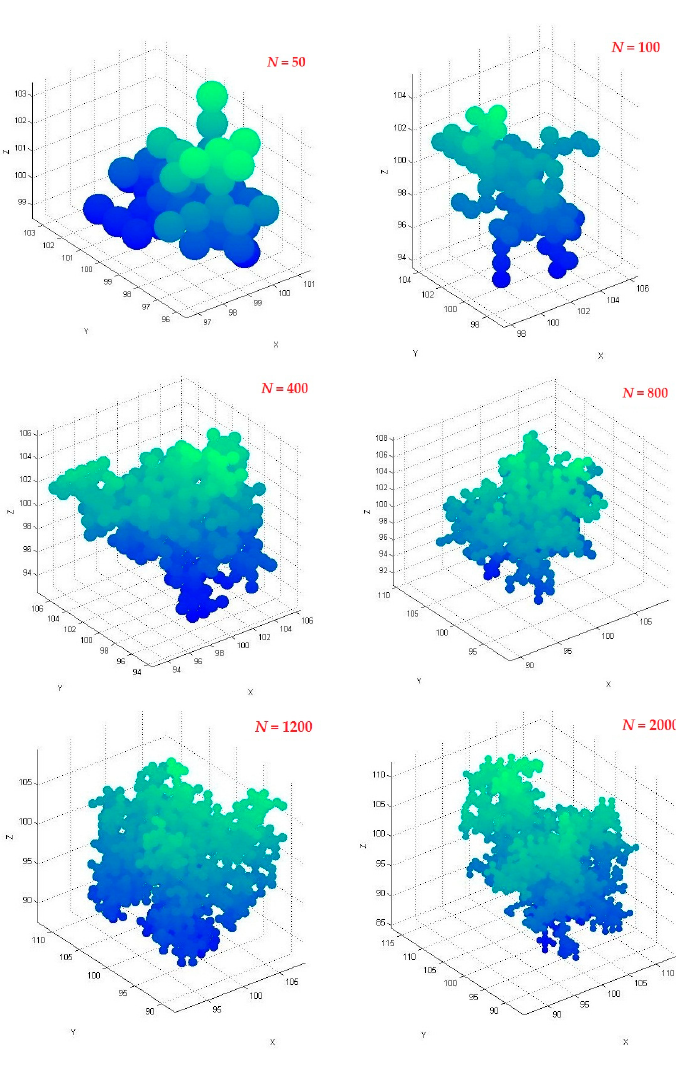
Figure 3. 3D DLA aggregates with versatile particle numbers.